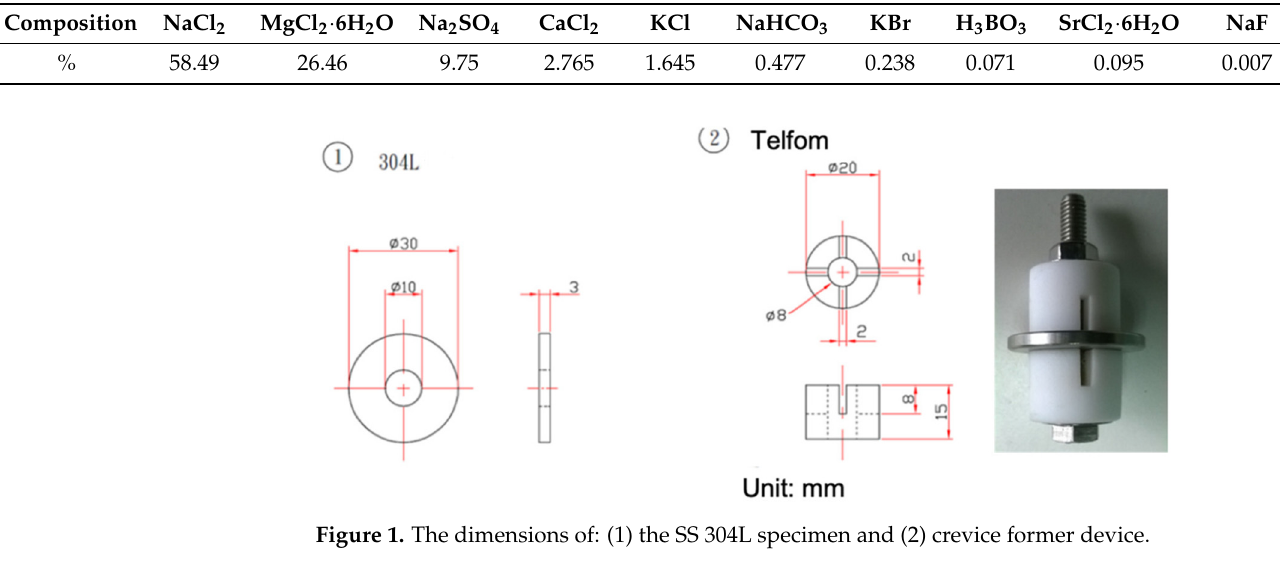
Table 2. The chemical composition of the simulated sea salt (wt%). Table 1. The compositions of the base metal of the 304L stainless steel plates (wt%).